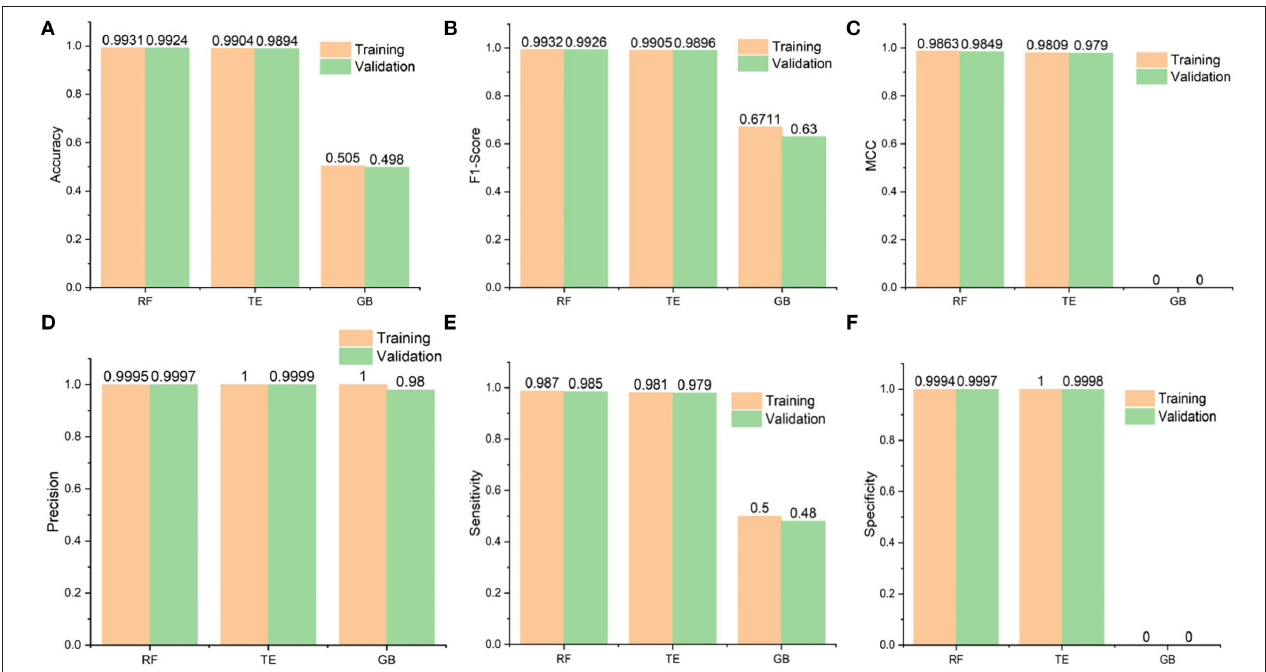
FIGURE 3 | Performance statistics of the algorithms used in the study. Additionally, it shows the training and 10-fold cross-validation results of the Random Forest (RF), Tree Ensemble (TE), and Gradient Boosted (GB) classifiers. (A) Shows the accuracy results of the classifiers and RF seems to perform best followed by the Tree Ensembl predictor, (B) in case of F1 scores, RF again performs better than the rest whereas the GB performance is worst, (C) whereas MCC values are also best for the RF but (D) Precision results are best for the TE during training and validation followed by the RF and GB, finally (E,F) for the Sensitivity and specificity, respectively, RF performs best and GB is constantly